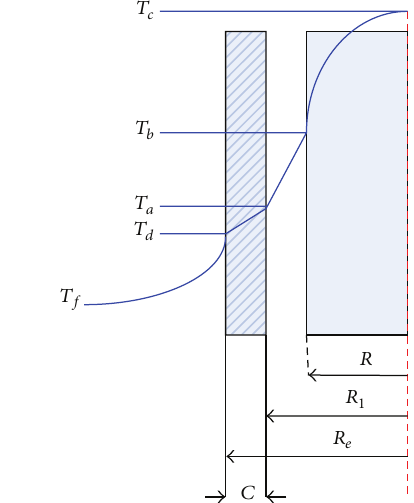
Figure 7: Temperature distribution in an assembly